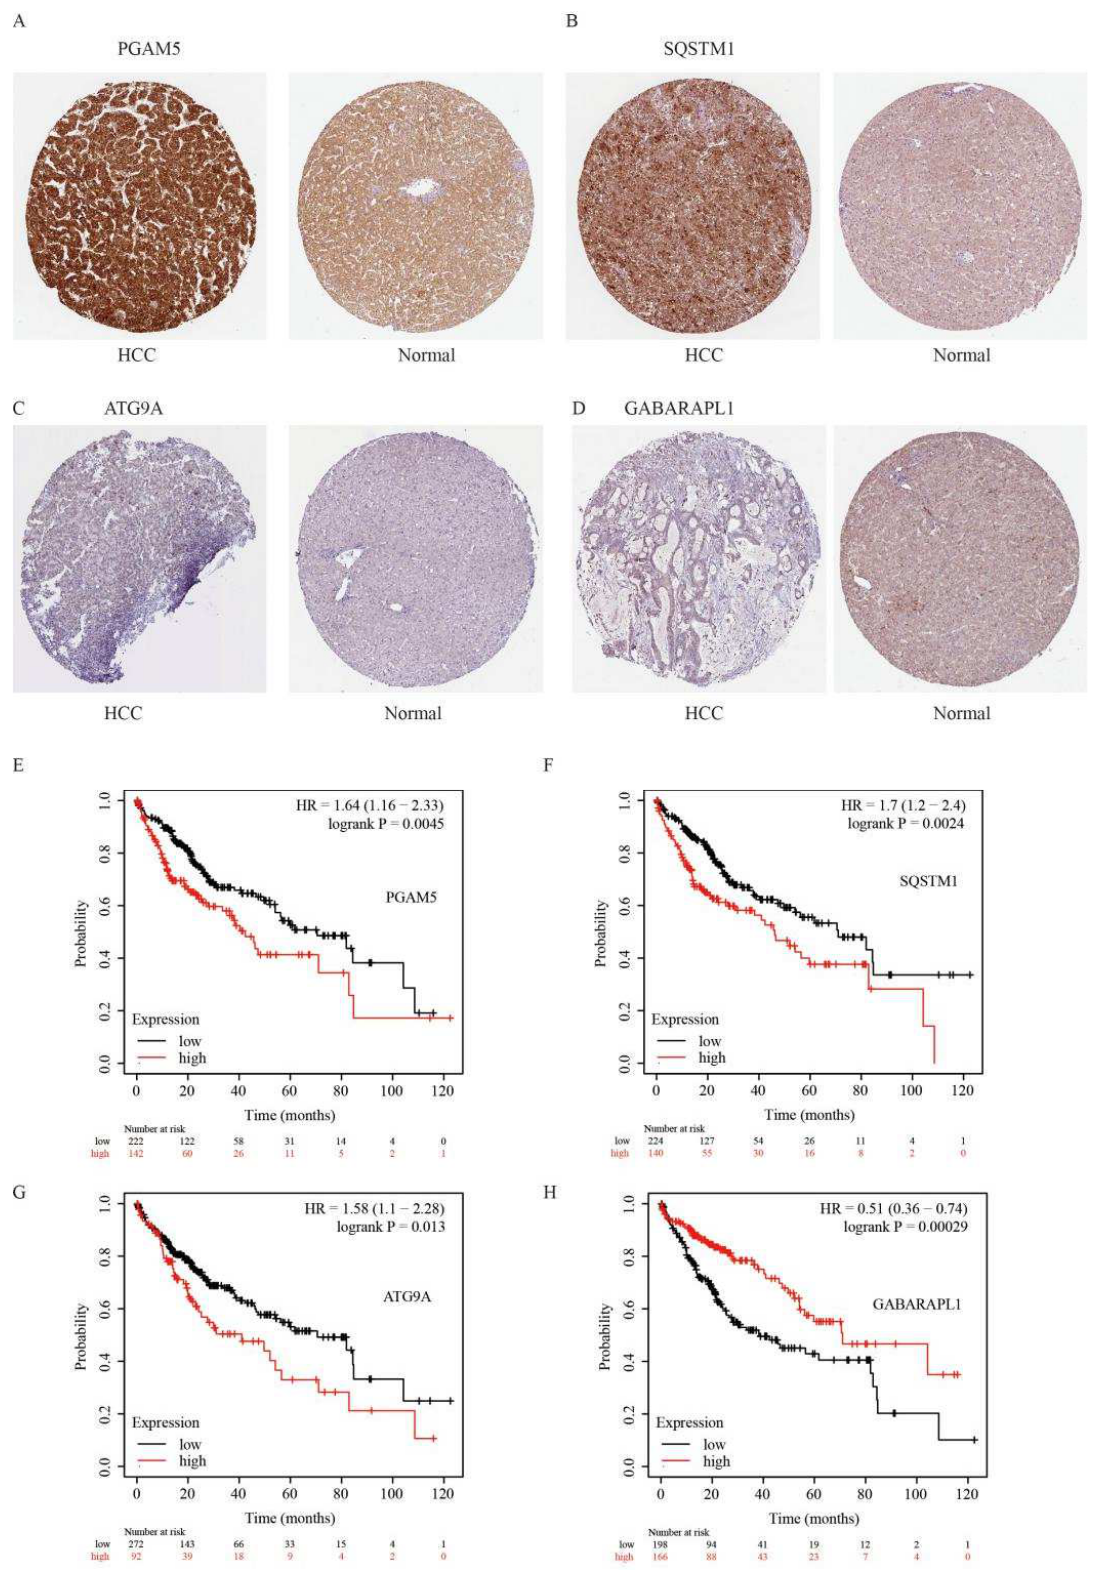
Figure 7. Immunohistochemical results and Kaplan–Meier curve of four genes in HCC tissues and normal tissues. ( A – D ) The immunohistochemical expression of four genes in normal tissues and HCC tissues in HPA online database. ( E – H ) The Kaplan–Meier curve of overall survival of patients with different expression of four genes in cell cycle.